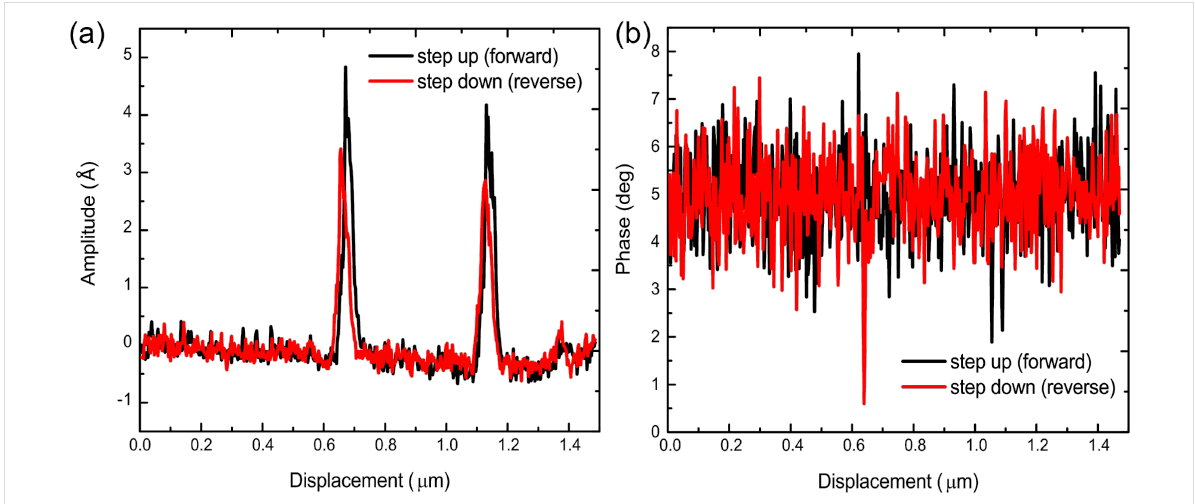
Figure 5: Line profile of (a) amplitude and (b) phase at uncovered steps acquired with the CR-mode at a contact resonance of 82 kHz. The data presented in this figure were acquired with tip B.